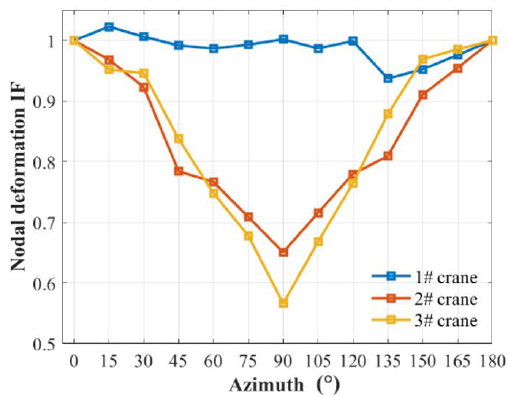
Figure 23. IF for peak deformation of the 119# node of boom-down crane.